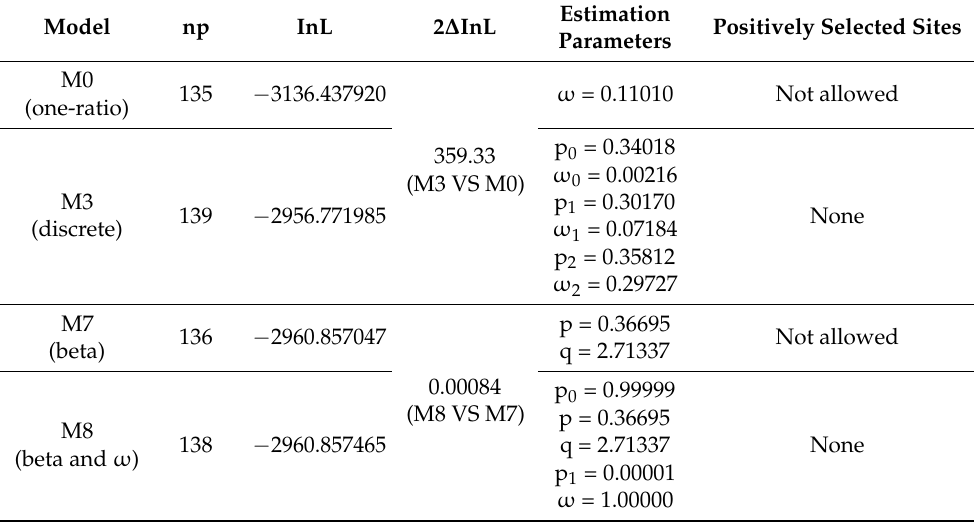
Table 2. Positive selection analysis of the TaGATA family by using the M0 and M3 and the M7 and M8